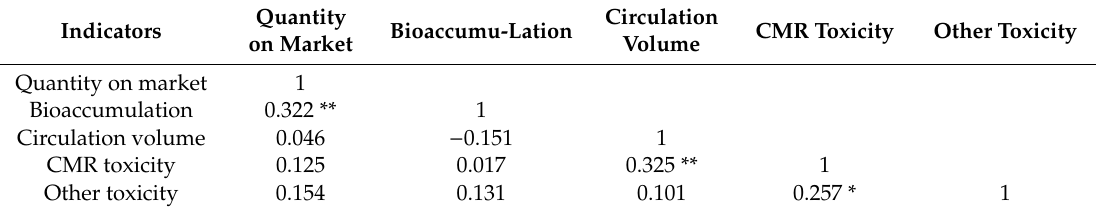
Table 5. Correlation coe ffi cients (r) for individual